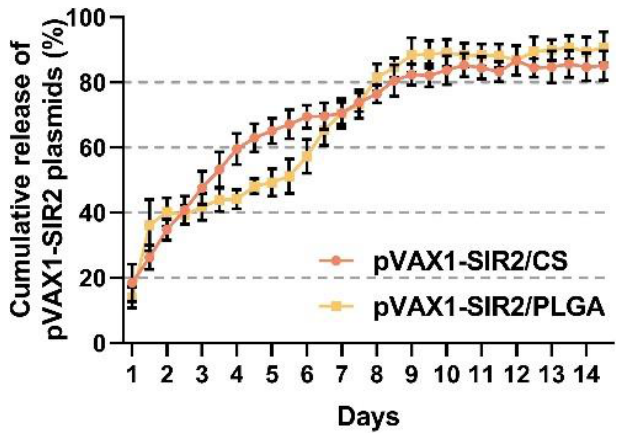
Figure 3. The release characteristics of PLGA and chitosan nanosphere loaded with pVAX1-SIR2 plasmids in vitro. The amount of free pVAX1-SIR2 plasmids in the supernatant was measured by the nanodrop microvolume spectrophotometer. Each group had three replications and each replication was investigated once. Values were represented as mean ± SD (n = 3).